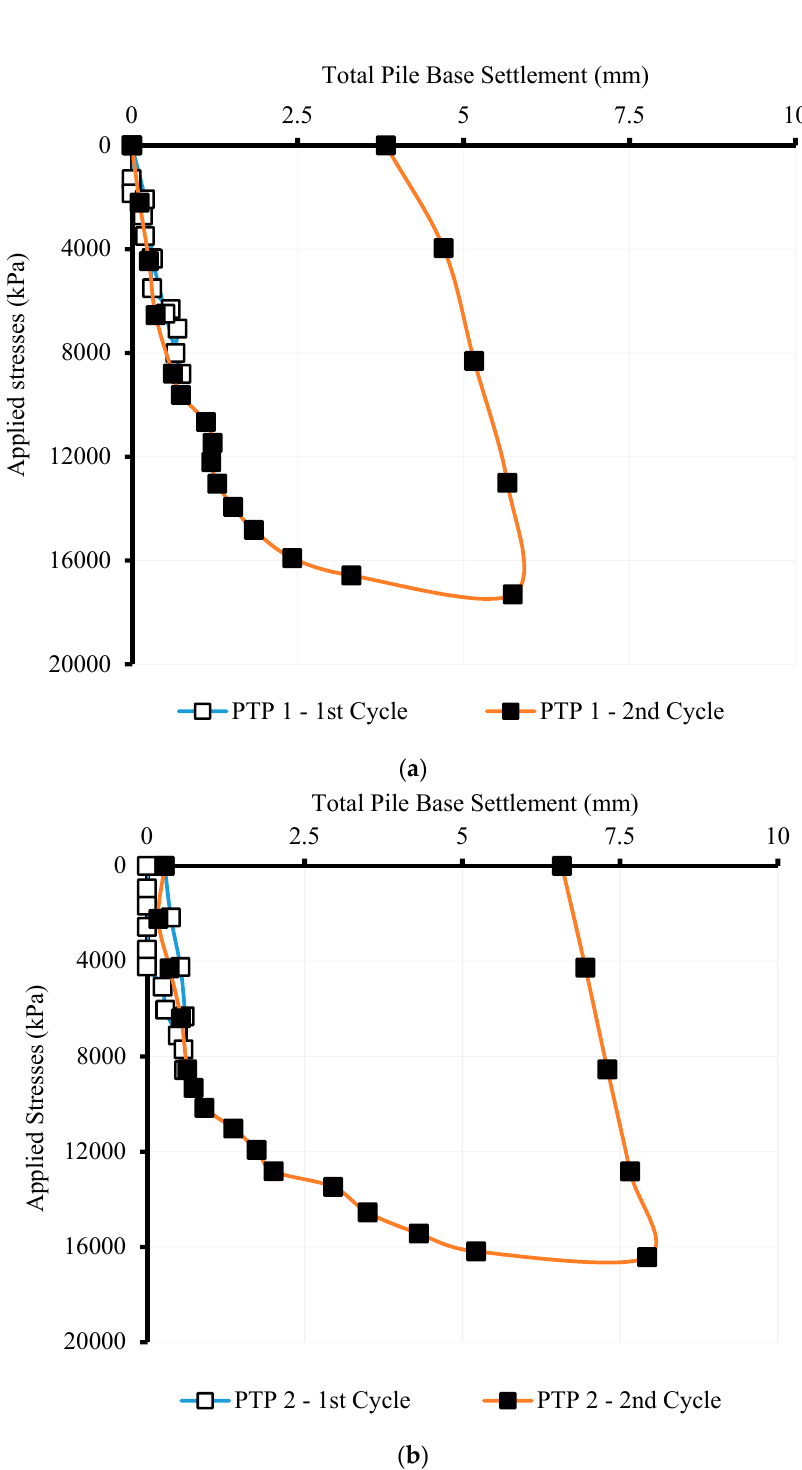
Figure 19. Different applied stress versus total pile base settlement in ( a ) BP# 1 and ( b ) BP# 2. Different total pile settlement versus time during BP# 1 and BP# 2 is presented in Figure 20. The settlement rate in the pile’s head is almost linear in the loading